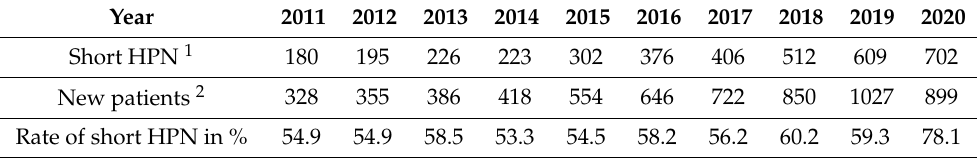
Table 7. Short term